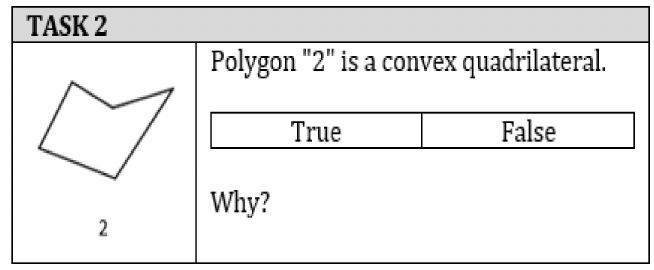
Figure 3. Task in the middle interview: recognize figure attributes.